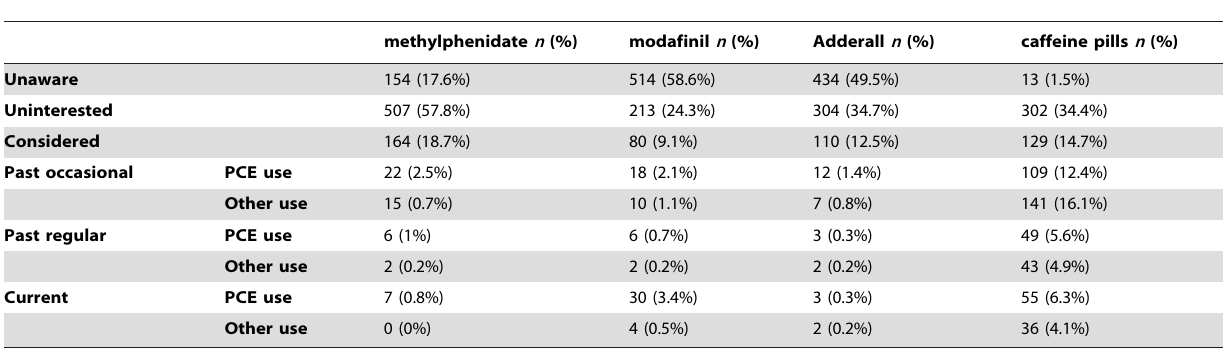
*Table 3 contains synthesized information from two questions. Prevalence – based on the six options listed – and purposes, focusing on PCE. Respondents could choose from 17 other purposes besides PCE; a subset of the data on other purposes is reported in Table 4. ‘PCE use’ was defined as a respondent who indicated PCE alone or in any combination; ‘other use’ was defined as a respondent who did not indicate PCE, but did indicate any other purpose.